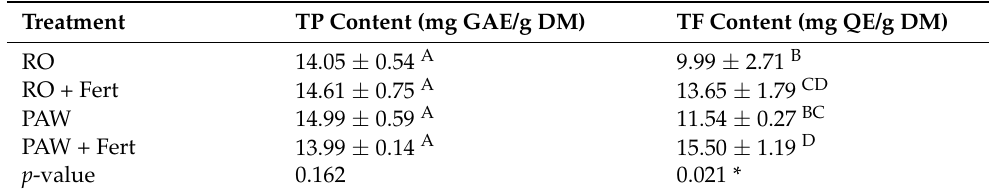
Table 5. TP content and TF content of water spinach grown under different treatments in Phase-2 pot experiment.